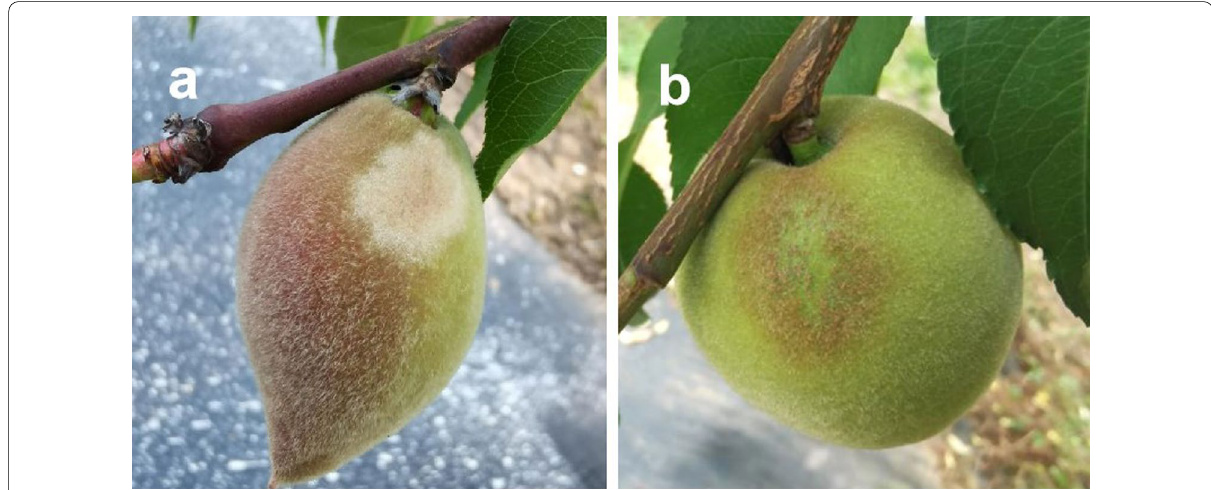
Fig. 5 Symptoms of powdery mildew. a White, spherical, and actively expanding spots on young fruitlet (Wuhan, 2022). b Older orange‑tan, rusty spot on green fruit (Wuhan,